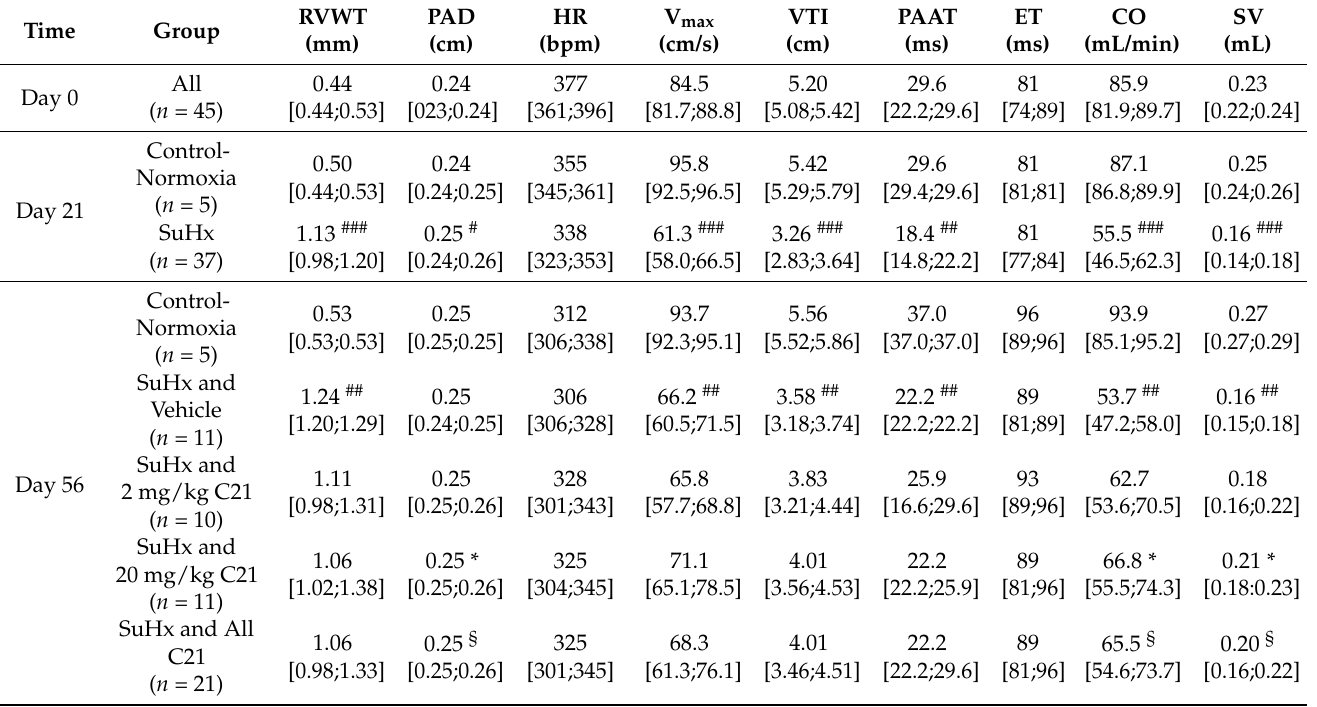
Table A1. Hemodynamic assessments by echocardiography on day 0, day 21, and Day 56.